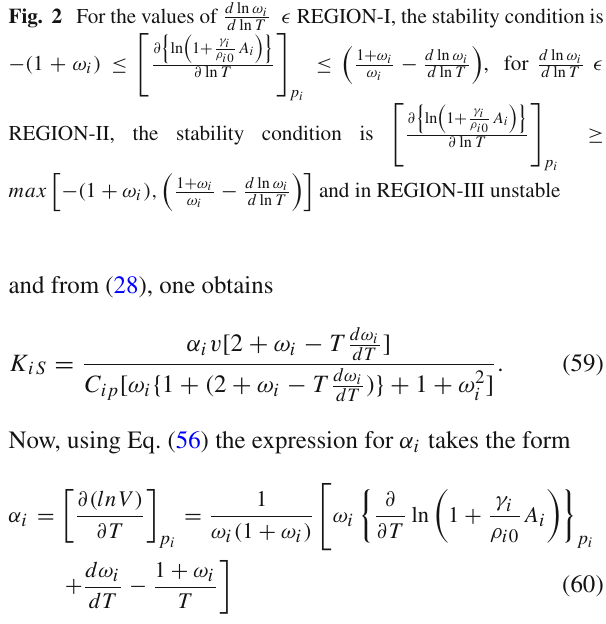
Fig. 2 For the values of d ln ω i